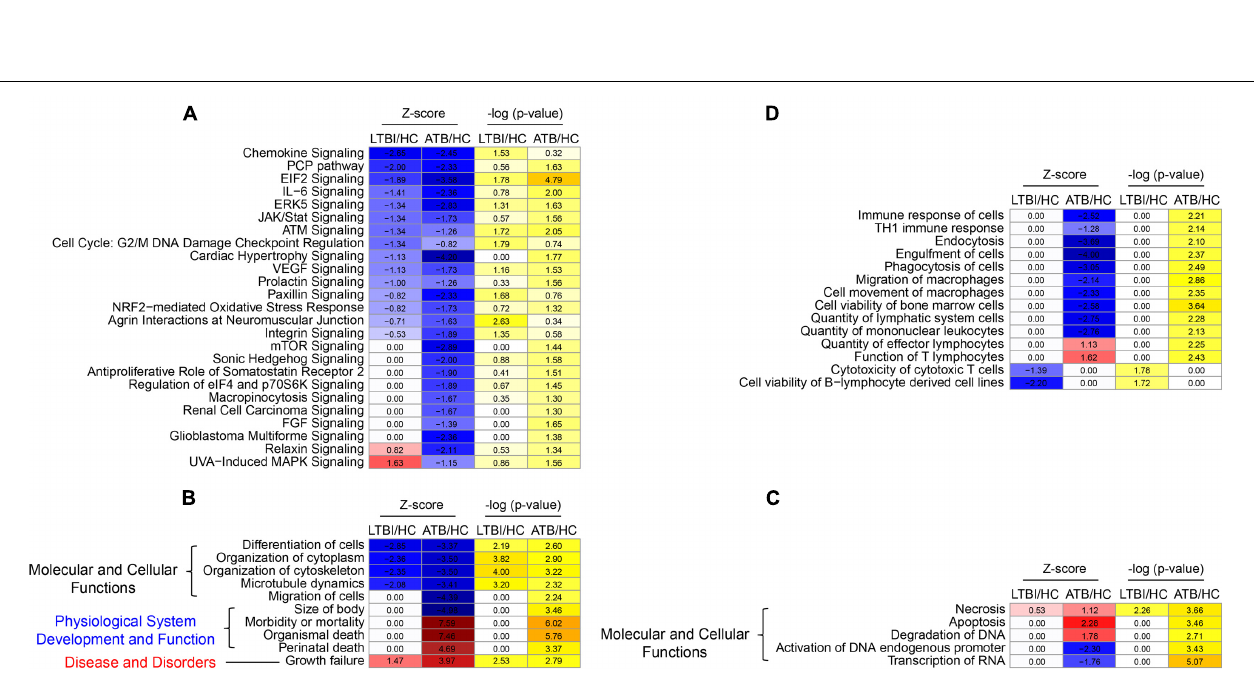
FIGURE 6 | Functional and pathway analyses using Ingenuity Pathway Analysis (IPA) among the three samples. (A) The IPA canonical pathway analysis indicating the 25 pathway ( Z -score (cid:54)= 0 in the LTBI or ATB samples). (B) The top-10 significantly changed items (| LTBI Z -score| + | ATB Z -score|) covered the three IPA categories including the “Molecular and Cellular Functions,” “Physiological System Development and Function,” and “Disease and Disorders.” (C) Five selected “Molecular and Cellular Functions” IPA items ( Z -score (cid:54)= 0 in the LTBI or ATB samples). (D) Some immune response related items ( Z -score (cid:54)= 0 in the LTBI or ATB samples). In addition, Z -score represents the IPA regulation trends [ Z -score > 0: up-regulation (red); Z -score < 0: down-regulation (blue)]. Colors indicate the estimate of base 10 log ratio of P -values that ranges from white (low) to orange (high) (–Log ( P -value) > 1.3: high significance level).